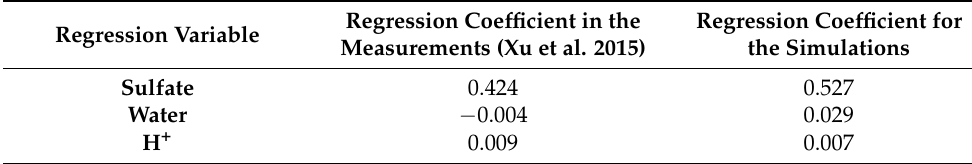
Table 2. Results for multiple linear regression of IEPOX OA with respect to sulfate, particle water and H +